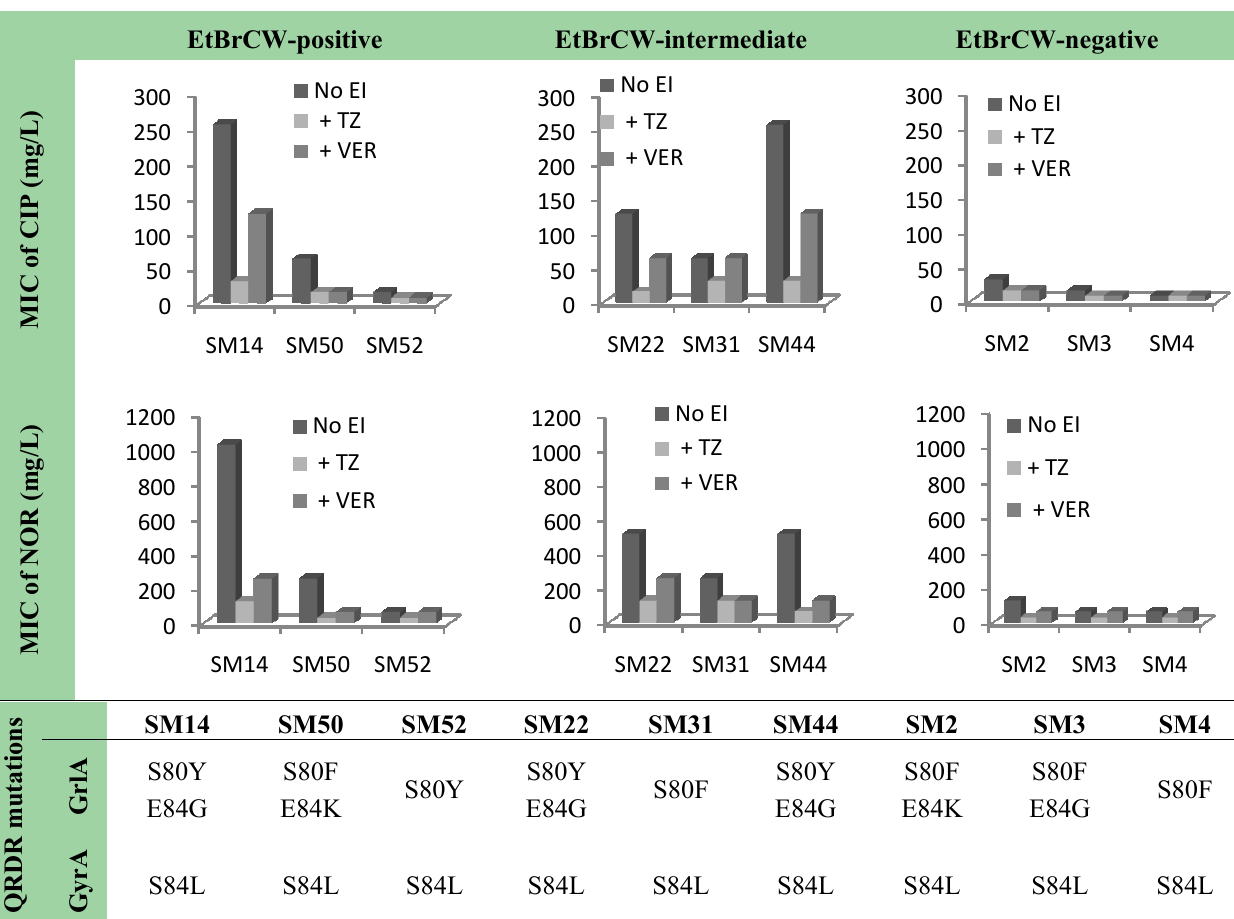
Figure 2. Effect of the efflux inhibitors thioridazine (TZ) and verapamil (VER), at subinhibitory concentrations (12.5 mg/L and 200 mg/L, respectively), on the minimum inhibitory concentration (MIC) values of ciprofloxacin and norfloxacin for representative isolates of the EtBrCW-positive, EtBrCW-intermediate and EtBrCW-negative groups, each carrying different mutations conferring fluoroquinolone resistance (data for EtBrCW- positive and -negative strains from our previous study,